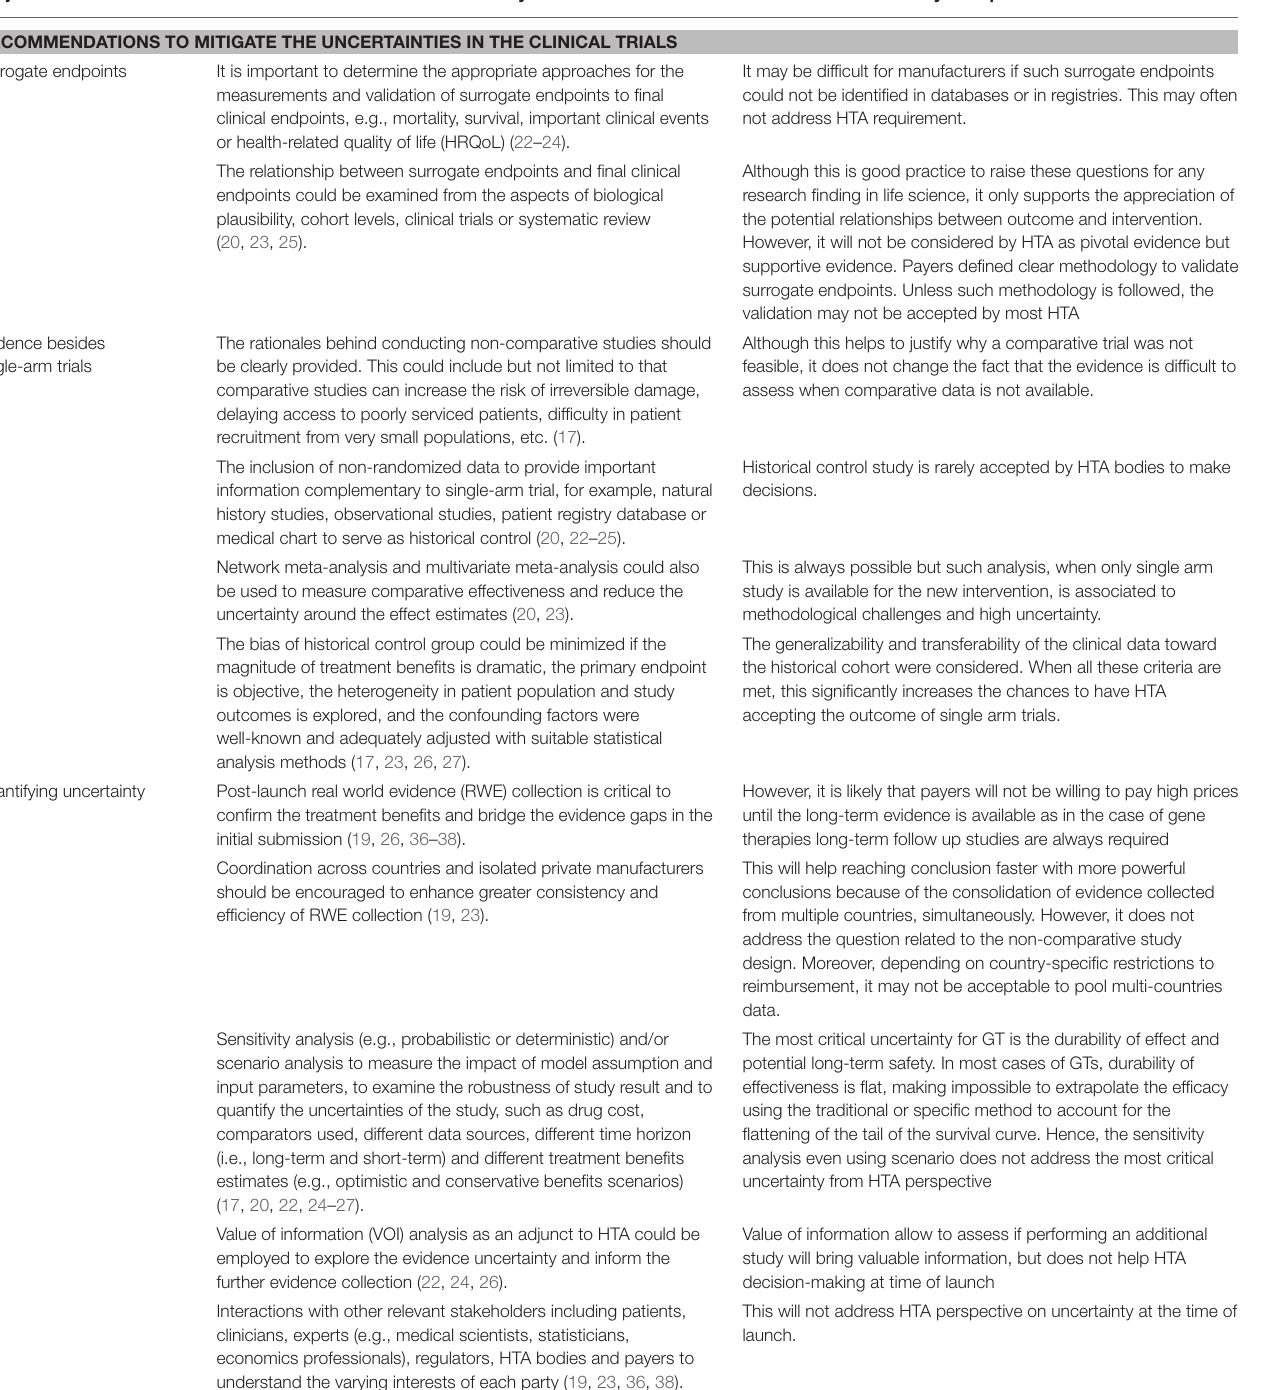
TABLE 1 | Recommendations from publications and our